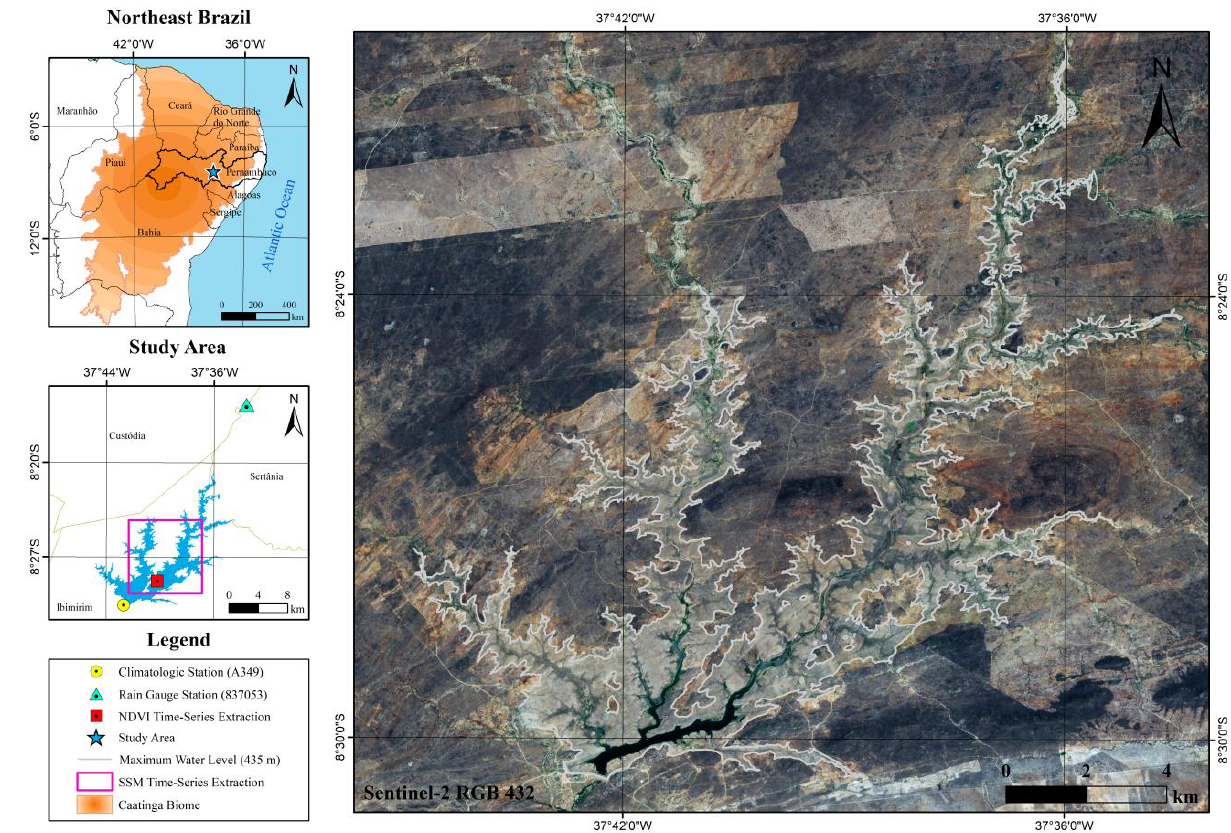
Figure 1. Location map of the Poço da Cruz reservoir, Pernambuco, Brazil.